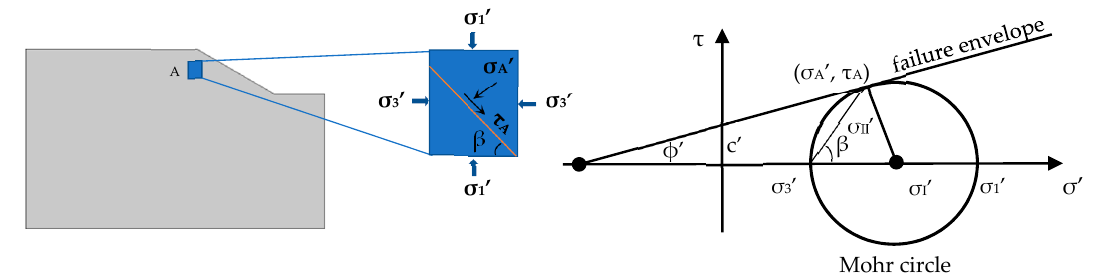
Figure 3. State of shear stress tensor and the corresponding Mohr circle.